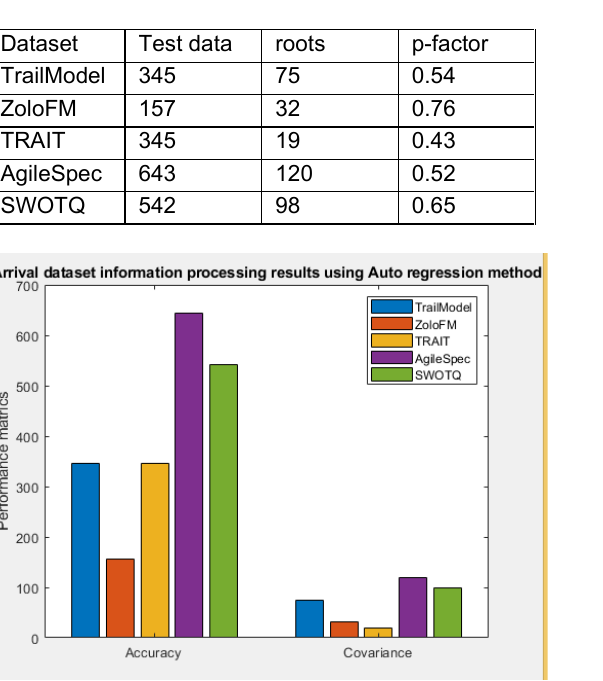
Figure 5. p-factor result from Redshit